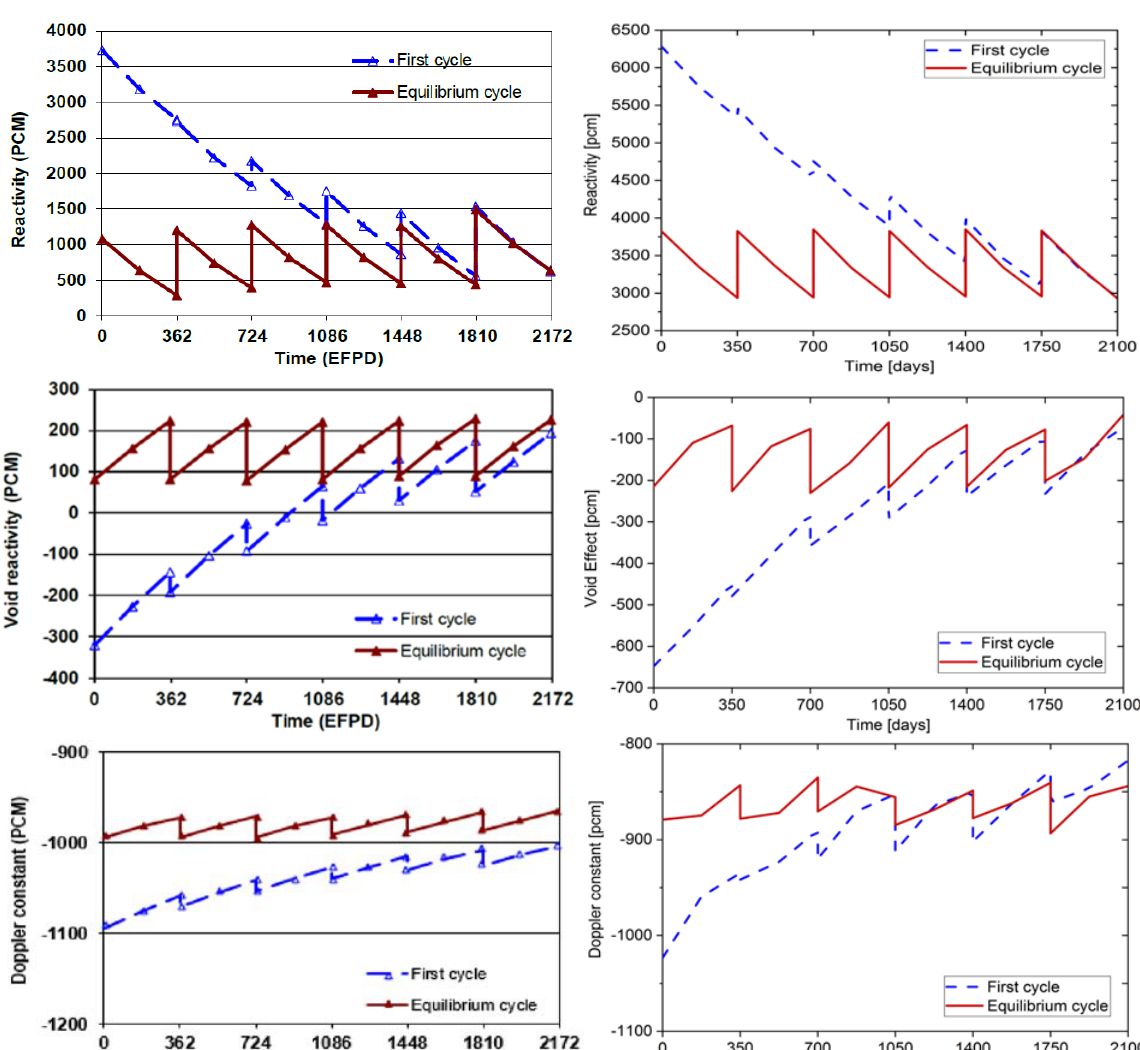
Figure 3. Reactivity (top), void effect (middle) and Doppler constant (bottom) evolution simulated with ERANOS (left) and Serpent